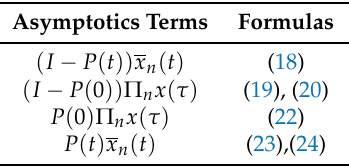
Table 2. The algorithm for finding the n -th order asymptotics terms, n ≥